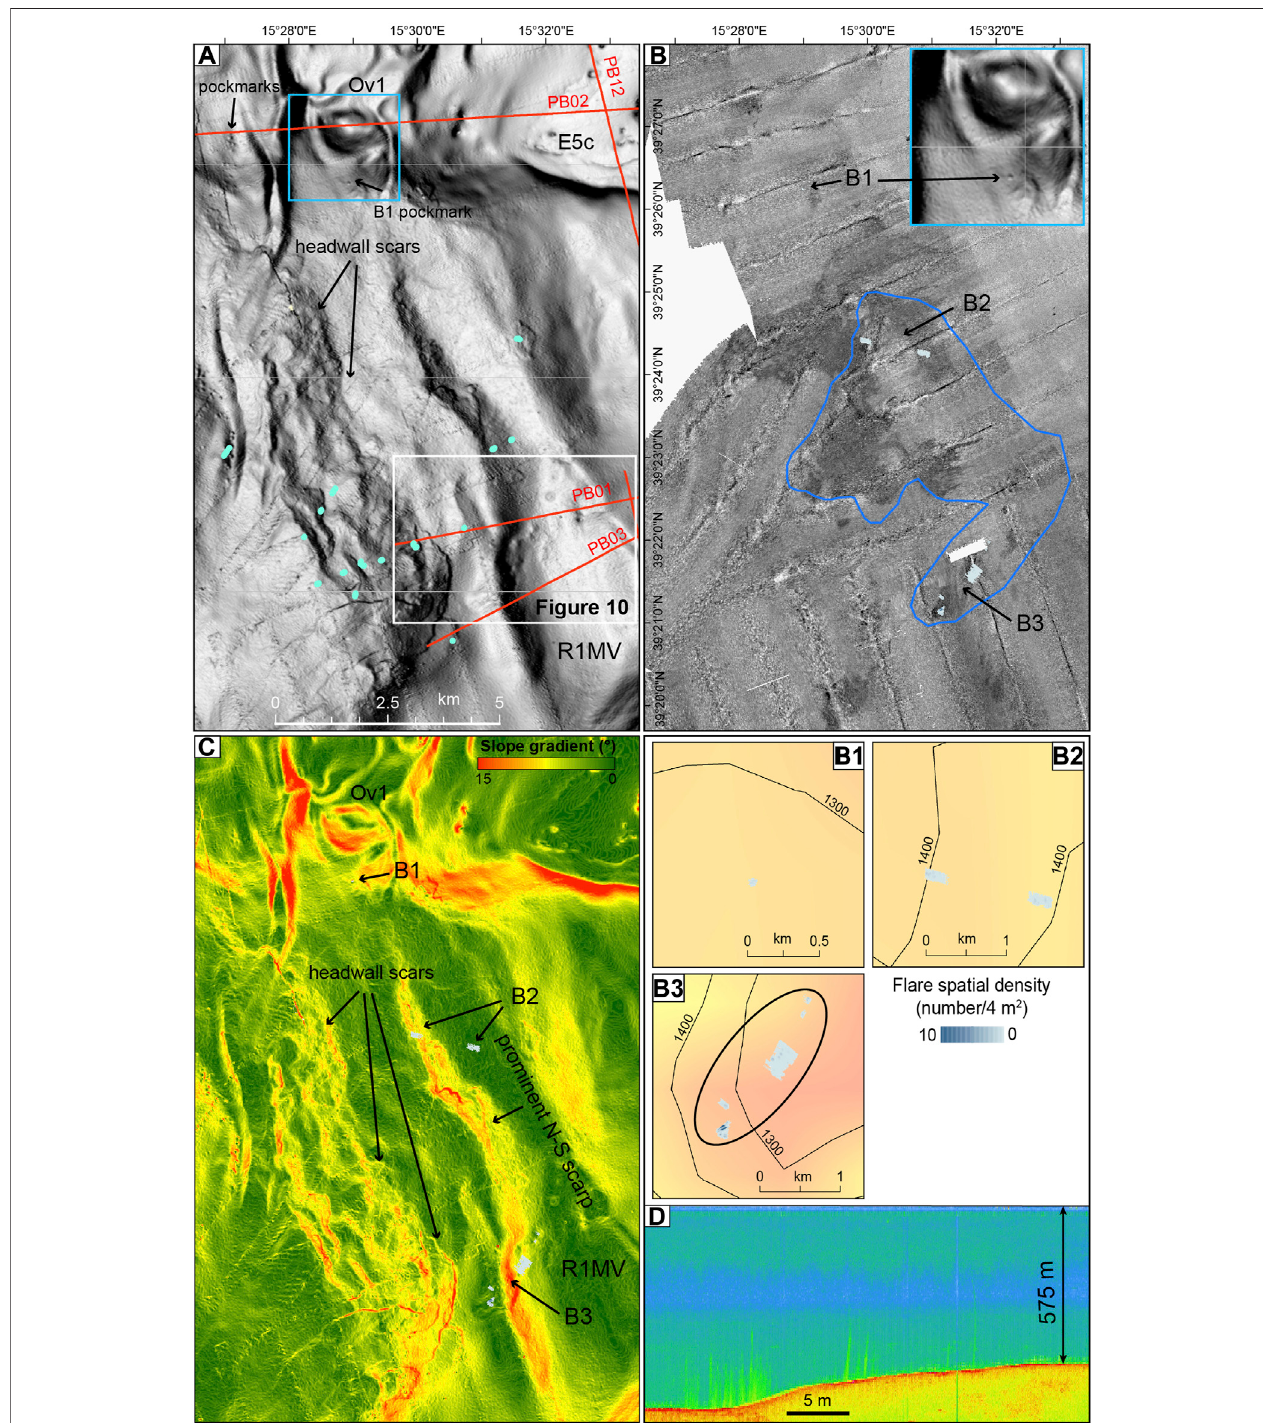
FIGURE 9 | (A) High-resolution MBES bathymetry of the northern sector of the study area with track lines of the MCS data (red), vertical bright spots identi fi ed in CHIRPpro fi les(smallbaby-bluecircles). (B) MBESbackscatterofthesea fl oor,theareaofshallowhigh-amplitudere fl ectorsinCHIRPpro fi lesisoutlinedinblue. (B1 – B3) are enlargements of fl are density superimposed to the depth of the Messinian re fl ector. Zoom in of the pockmark located on the southern fl ank of Ov1 is framed in the upper right corner. (C) Slope gradient calculated from the MBES bathymetry showing the presence of headwall scars and the N − S scarp connecting Ov1 with the areas of R1MV fl ares. (D) Stacked view of gas fl ares detected in the water column by the MBES EM302 corresponding with the ellipsis in (B3) . The area is outlined in Figure 2B .